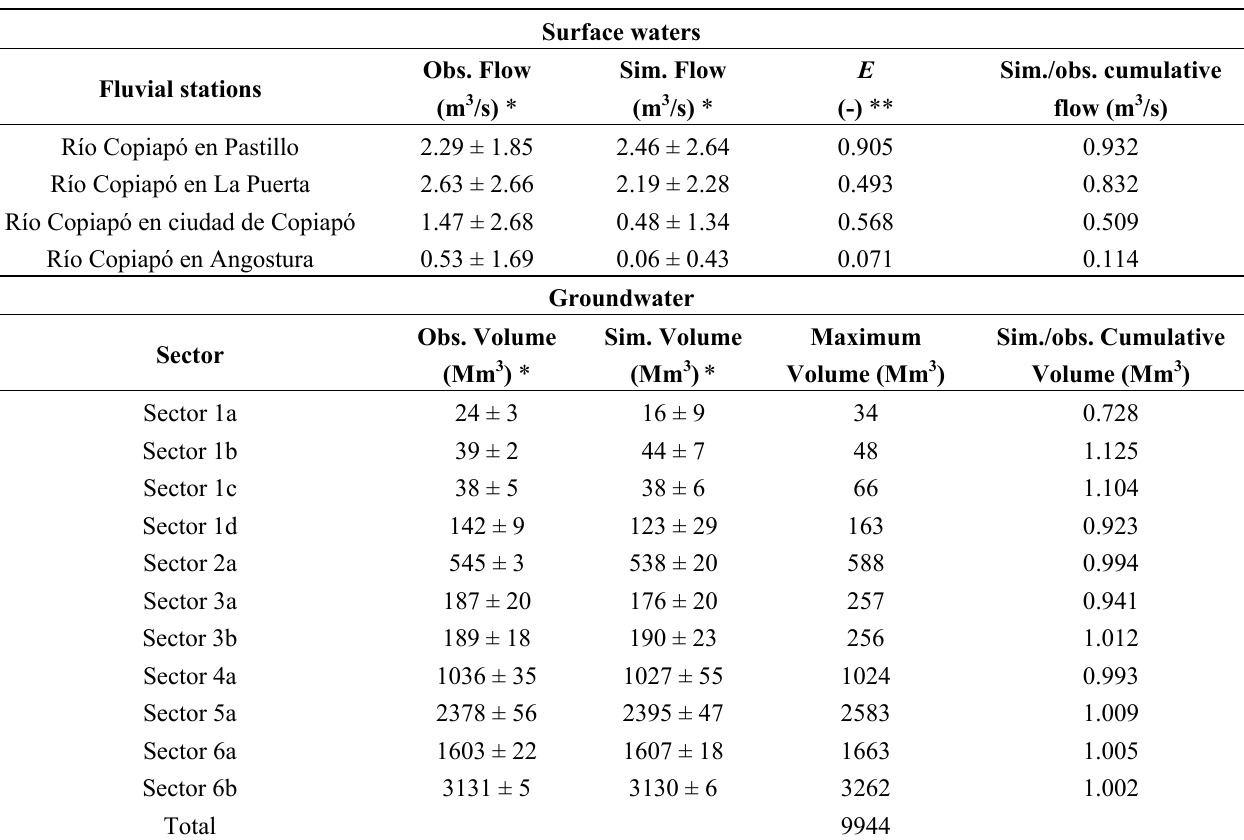
Table 5. Observed and simulated data obtained during the entire calibration